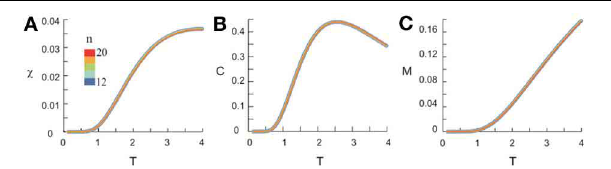
FIGURE 9 | Shuffled data does not exhibit scaling behavior. Original data was the same as shown in Figure 4 . At T = 1, we calculated the individual pattern probabilities based on independent Poisson processes to generate nLFPs with the same empirically measured rate for each cortical site. Using the same method applied to original data, we calculate χ , C , and M as functions of T . In contrast to the original data, the curves for systems of different sizes are almost identical for χ (A) , C (B), and M (C) . For visual clarity, curves with different sizes have different widths.